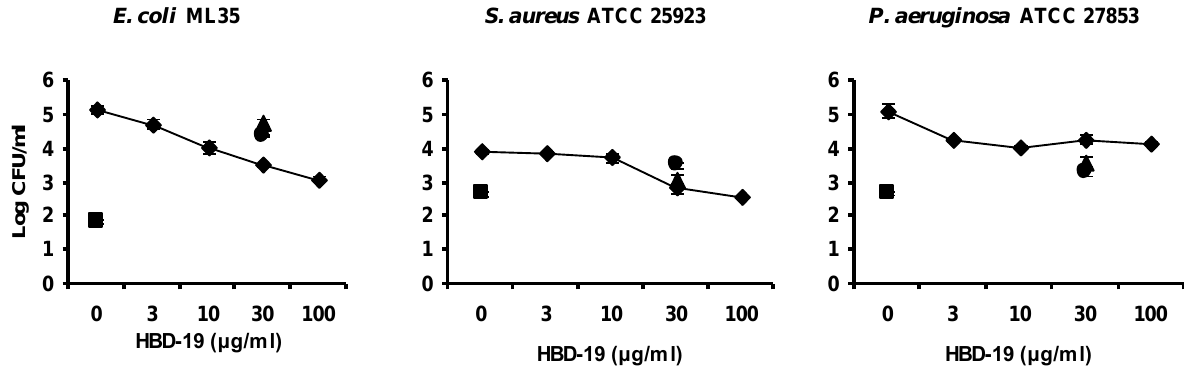
Figure 3. Antimicrobial activity of HBD-19 against three bacterial species. The antimicrobial activity of HBD-19 was evaluated by colony forming unit (CFU) assay and the results were plotted on a logarithmic scale. The experiments were carried out using four different concentrations of HBD-19 (3 μg/mL, 10 μg/mL, 30 μg/mL, 100 μg/mL) with 20 mM lysozyme (square) as the positive bactericidal control. The bactericidal activity of 30 μg/mL HBD-19 was also tested in the presence of 150 mM NaCl (triangle) and 2 mM dithiothreitol (circle). The bacteria used were Escherichia coli ML35, Staphylococcus aureus ATCC 25923, and Pseudomonas aeruginosa ATCC 27853. The results shown are the average of six complete experiments with E. coli , four with S. aureus and five with P. aeruginosa; while some points on the graphs represent more experimental repetitions. Error bars show standard